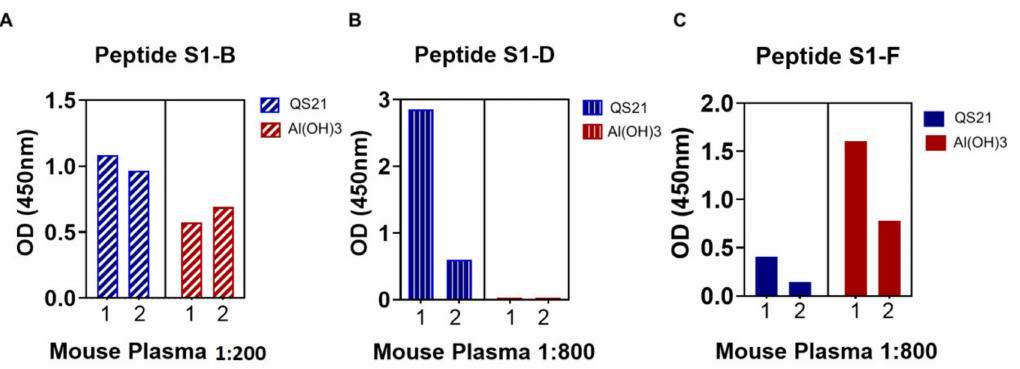
Figure 4. Antibody duration between two adjuvants. The graphs above are the results of antibody testing via ELISA on blood from two time points (1 and 2): 1 is 10 days after the 6th vaccination and 2 is three months after 1. Al(OH) 3 can generate a longer antibody response than QS21 ( B , C ). However, QS21 can induce a higher antibody response to some antigens, such as that seen in S1-B ( A